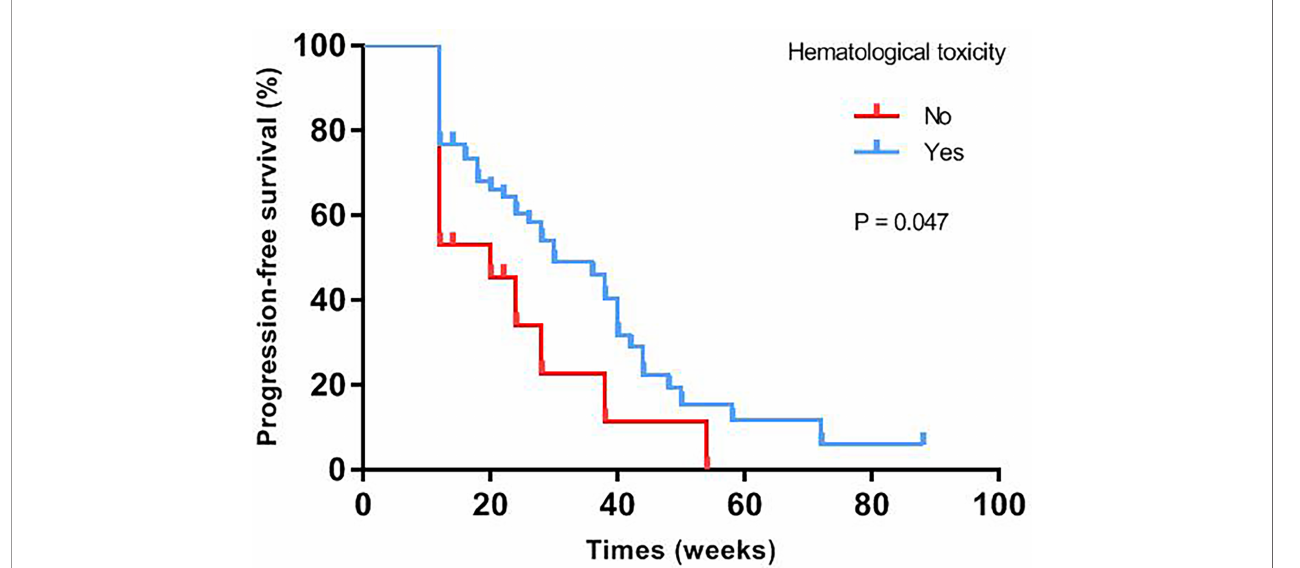
FIGURE 1 | PFS was compared between patients with or without hematological toxicity.